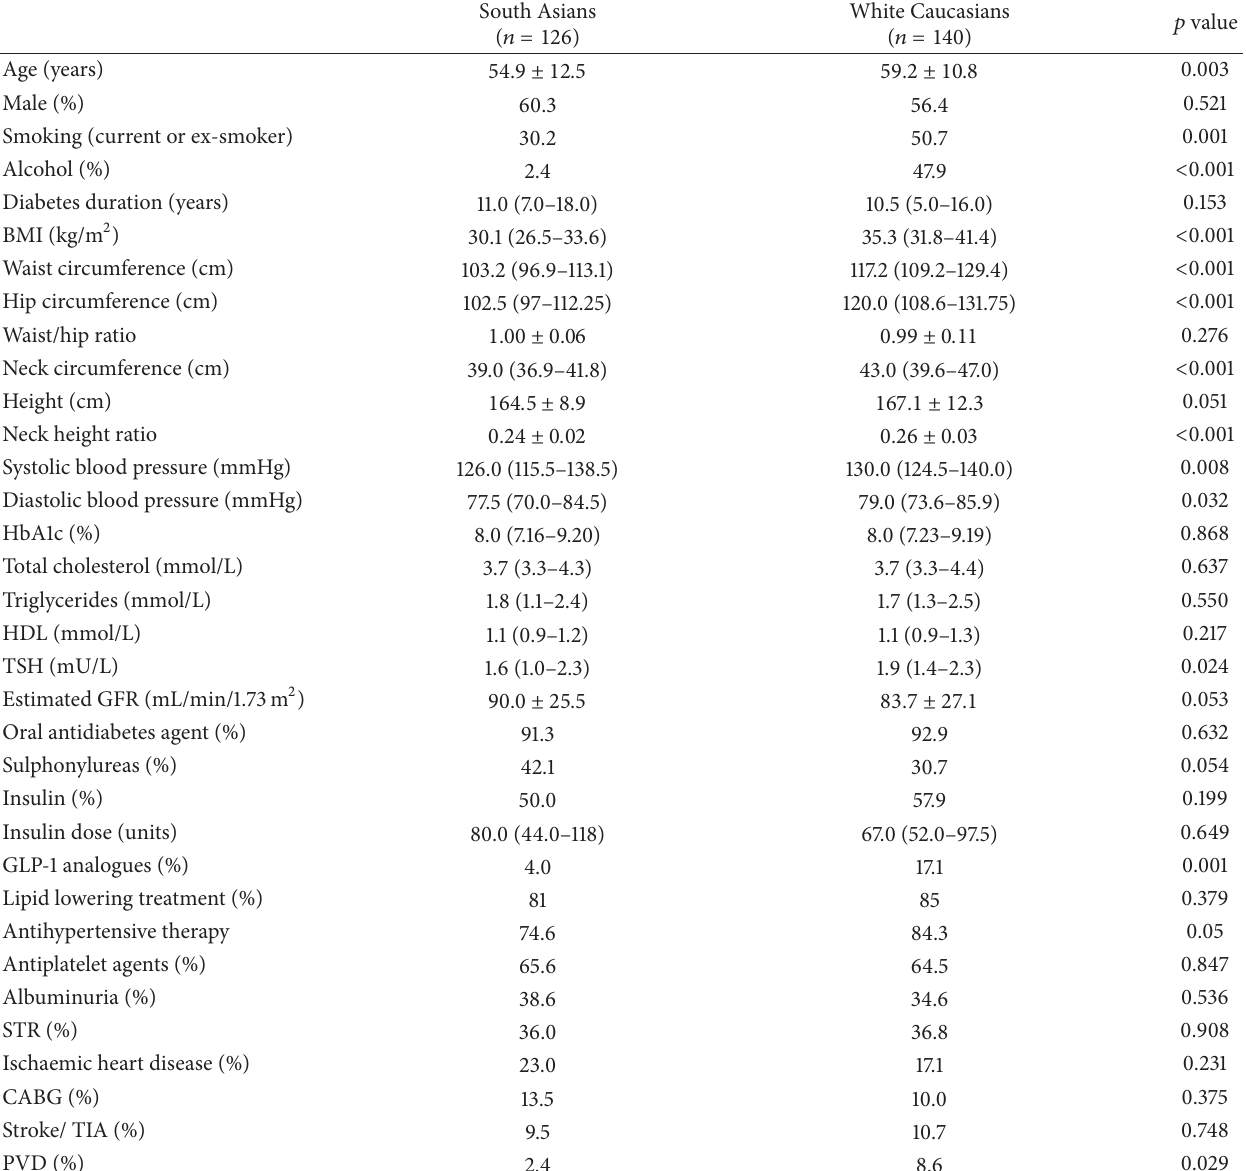
Table 1: Summary of baseline characteristics in relation to ethnicity. Data are presented as median (IQR) or mean ± 1SD depending on data distribution. The percentages represent % of participants in the ethnic group. STR: sight threatening retinopathy defined as preproliferative or proliferative retinopathy or maculopathy or previous laser treatment. TIA: transient ischaemic attack. PVD: peripheral vascular